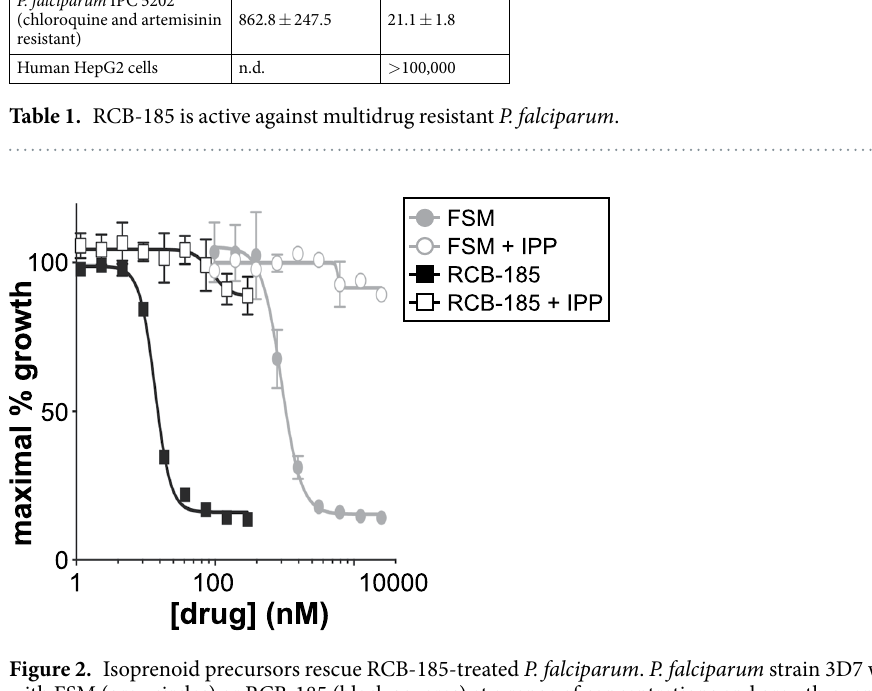
Figure 2. Isoprenoid precursors rescue RCB-185-treated P. falciparum . P. falciparum strain 3D7 was treated with FSM (grey circles) or RCB-185 (black squares) at a range of concentrations and growth quantified by PicoGreen (Life Technologies) after 72 h, as previously described 35 . The downstream isoprenoid precursor IPP rescues both FSM and RCB-185-treated parasites (open shapes) indicating the fosmidomycin analog is a specific inhibitor of the MEP pathway in P. falciparum . Shown is a representative graph from 3 or more independent